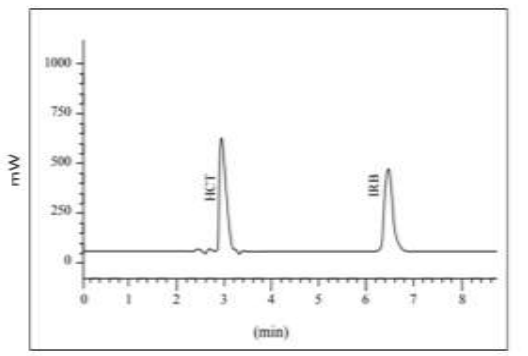
Figure 1. Chromatogram showing peaks of HCT (30 µg/ml) and IRB (80 µg/ml) IRB and HCT showed linearity in the specified concentrations with correlation coefficient equals to 0.999 for both drugs and relative standard deviation (RSD) less than 2.00. Calibration curves are shown in figure 2 (A and B). 4